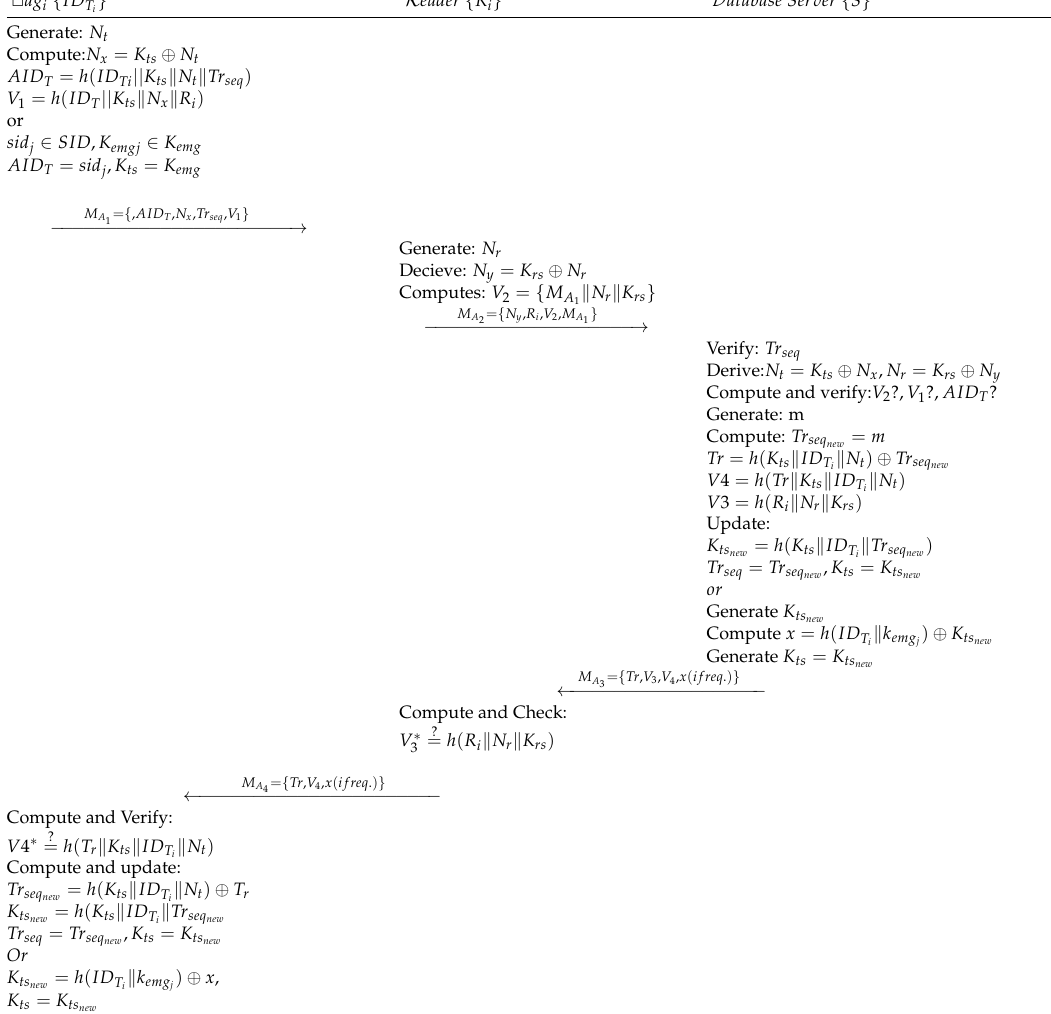
Figure 3. Gope-Hwang’s proposed authentication